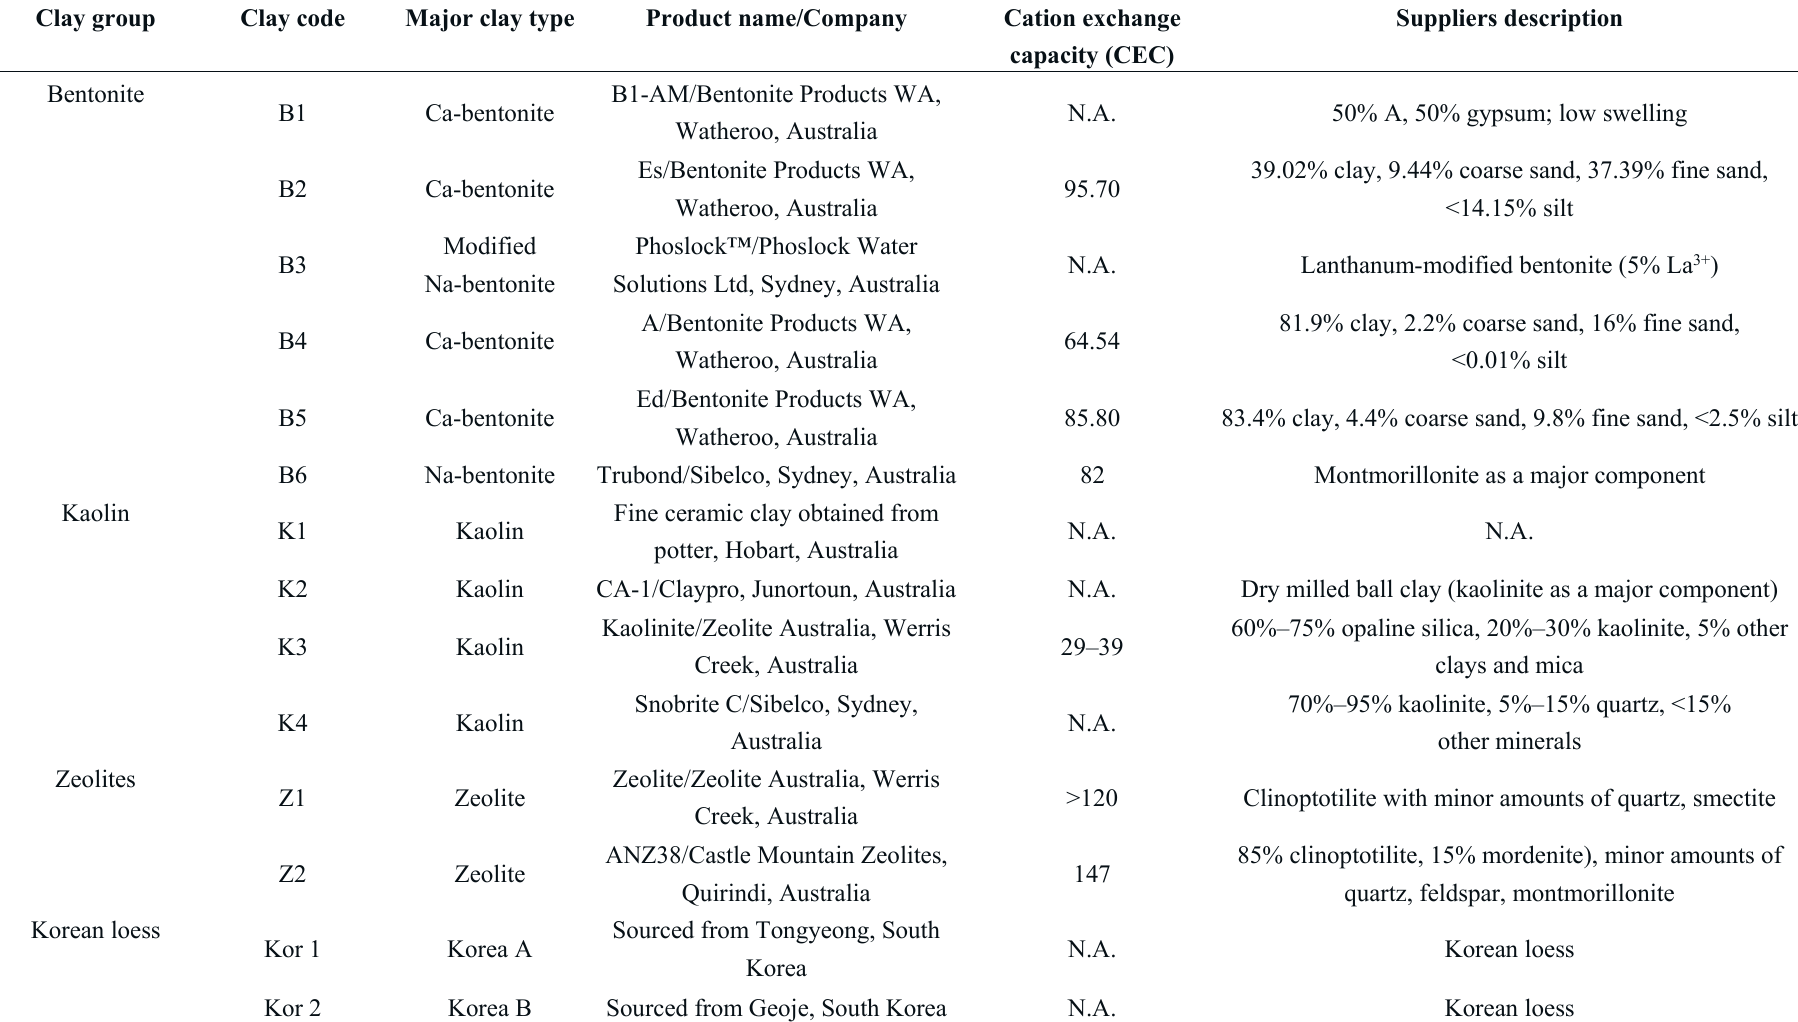
Table 1. Description of clay types employed in this study as provided by the